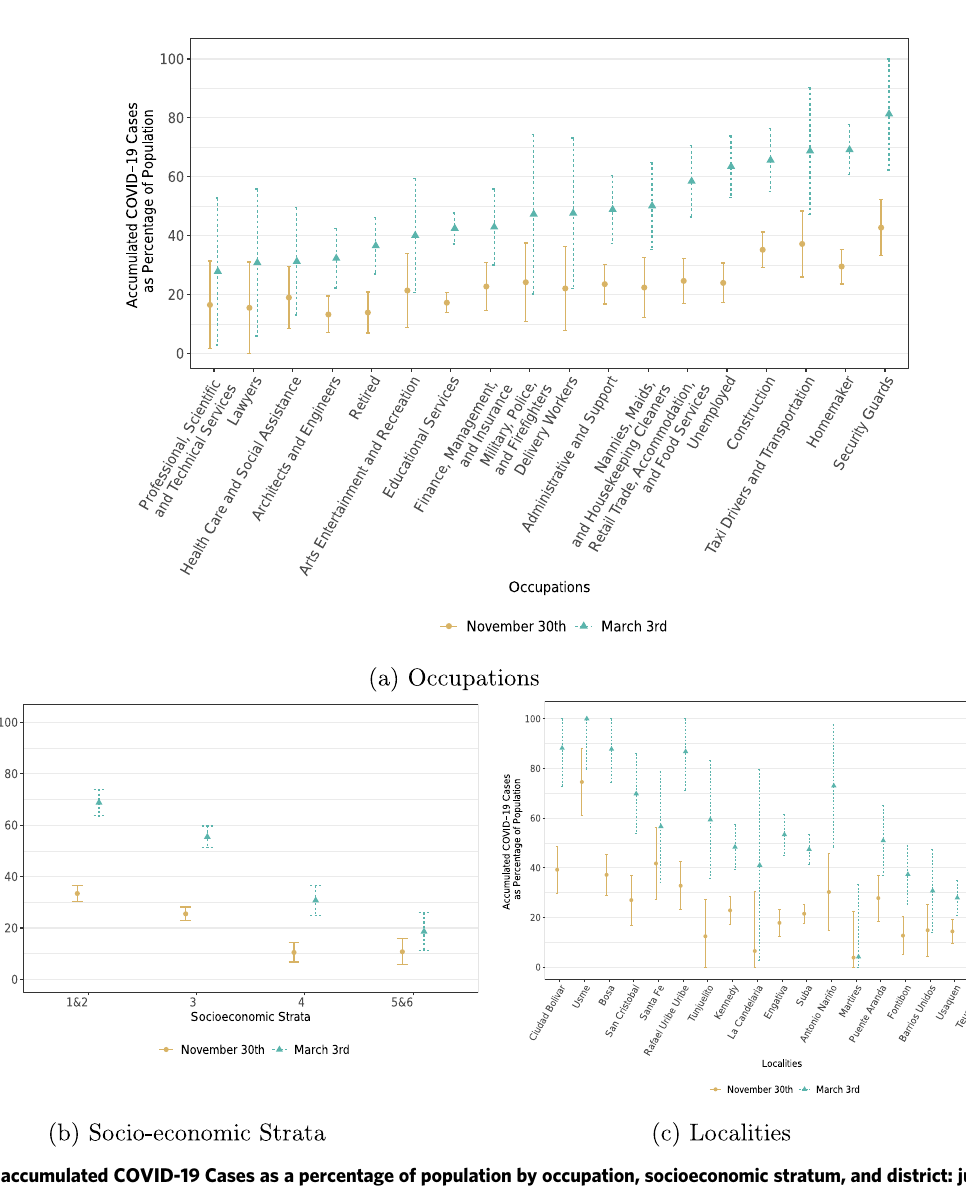
Fig. 2 Estimated accumulated COVID-19 Cases as a percentage of population by occupation, socioeconomic stratum, and district: june 1st — November 30th and June 1st — March 3rd. a By occupations. b By socioeconomic strata ( c ) by Bogota ’ s districts, sorted by district ’ s mean stratum. Dots represent weighted point estimates of accumulated cases between June 1st – November 30th (brown dots) and and June 1st – March 3rd (teal triangles) ( n = 42,164). Error bars denote 95% con fi dence intervals. Observations are weighted by occupation to be representative of the Bogota population. Supplementary Tables 4, 6, 7 show the sample decomposition by occupations, Bogota ’ s districts, and socioeconomic stratum